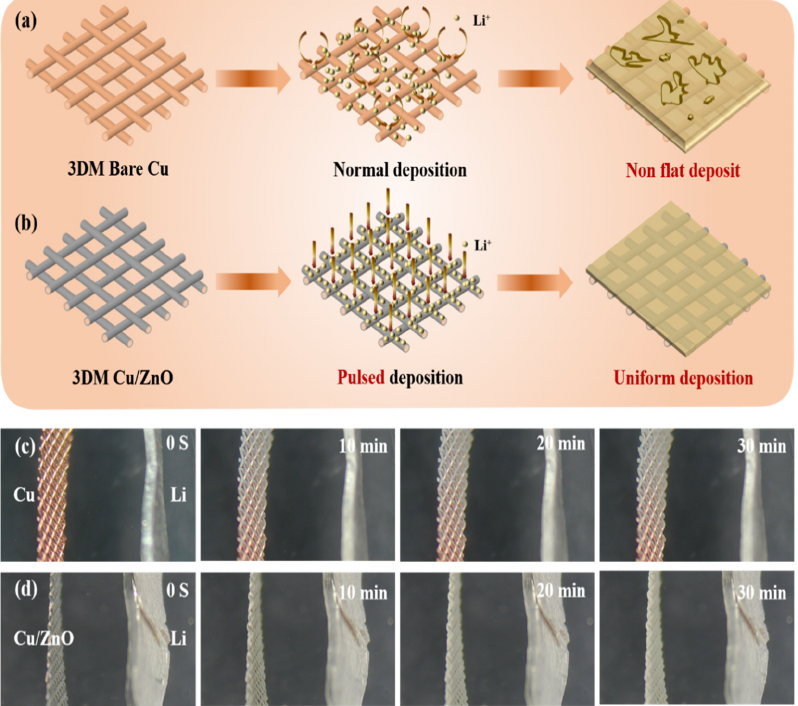
Figure 3. Schematic diagram of lithium plating on the ( a ) 3DM Bare Cu with normal Li deposition and ( b ) 3DM Cu/ZnO current collector with an applied pulsed current. Digit photo images of the Li deposit ( c ) 3DM Bare Cu with normal and ( d ) 3DM Cu/ZnO with an applied pulsed current after di ff erent deposition durations.